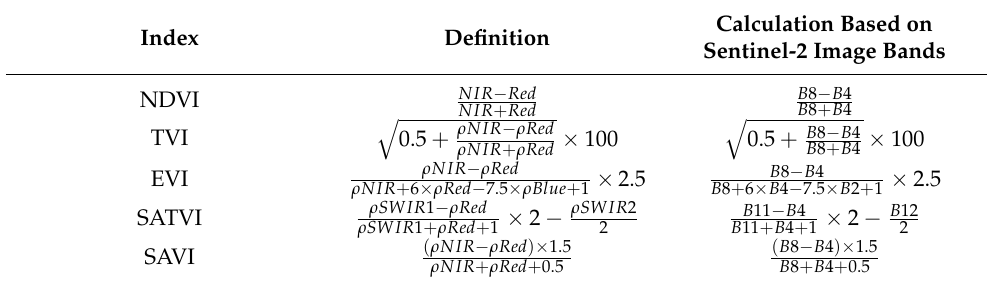
Table 2. Definition and calculation of the selected spectral